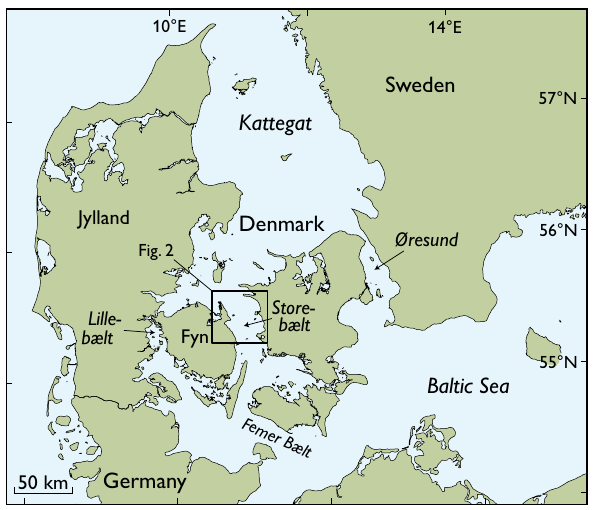
Fig. 1. Map of Denmark and the surrounding area showing the location of the study area.